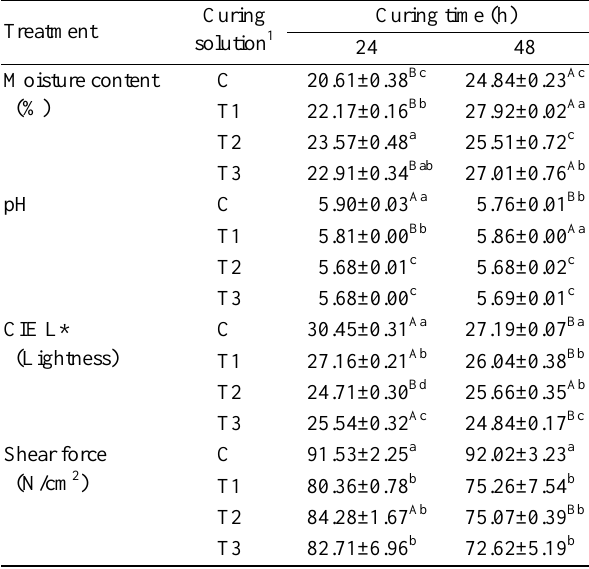
Table 1. Effect of curing time on the moisture content, pH, CIE L* and shear force of beef jerky